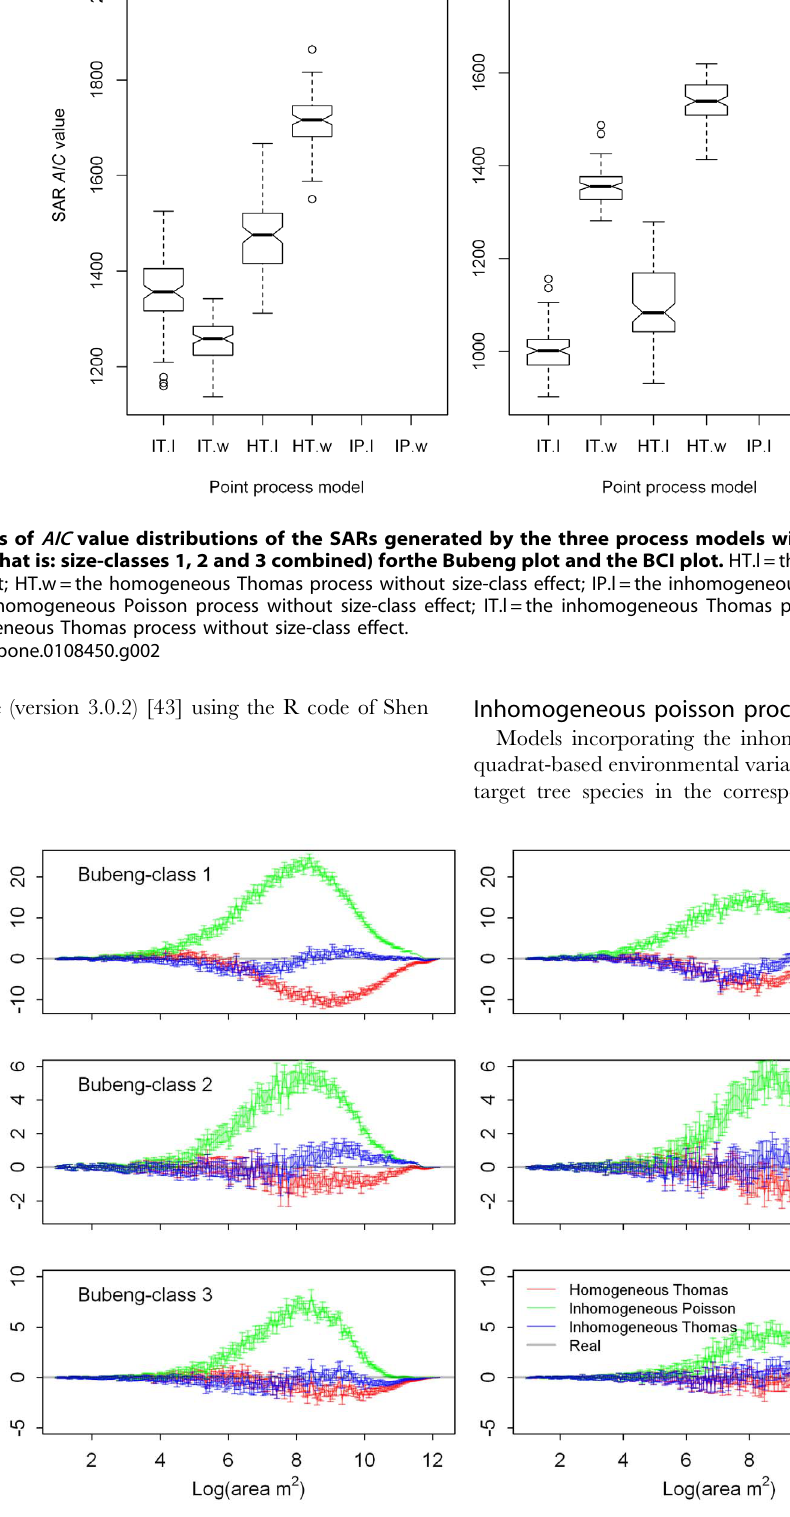
Figure 3. The observed and predicted species–area curves for the three process models for size-classes 1, 2 and 3 of the Bubeng plot and the BCI plot. The bars represent 95% confidence intervals.